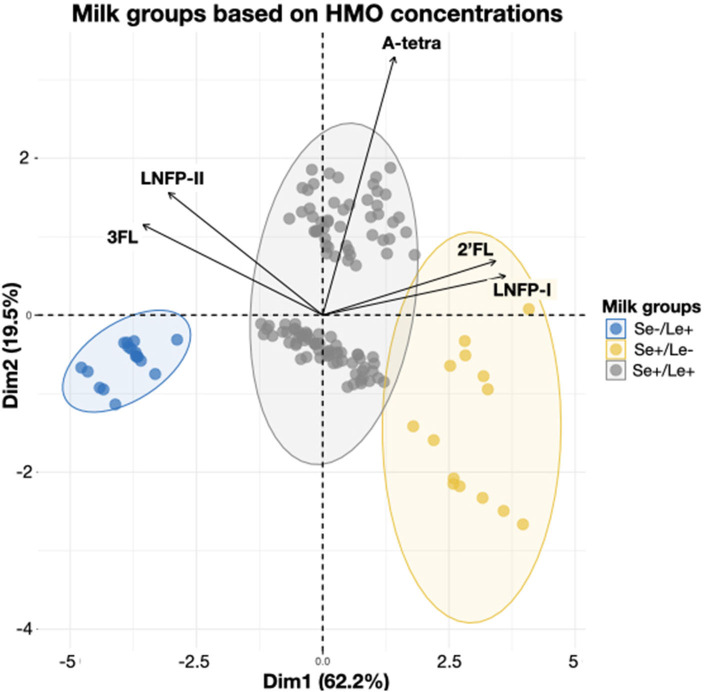
Individual mothers grouped based on 5 HMO concentrations at 3 months. The HMOs concentrations are used to determine the milk group as defined in (22). Secretor-positive groups are even further separated by the presence or absence of A-tetra. Ellipses represent the 95% percentile of confidence.